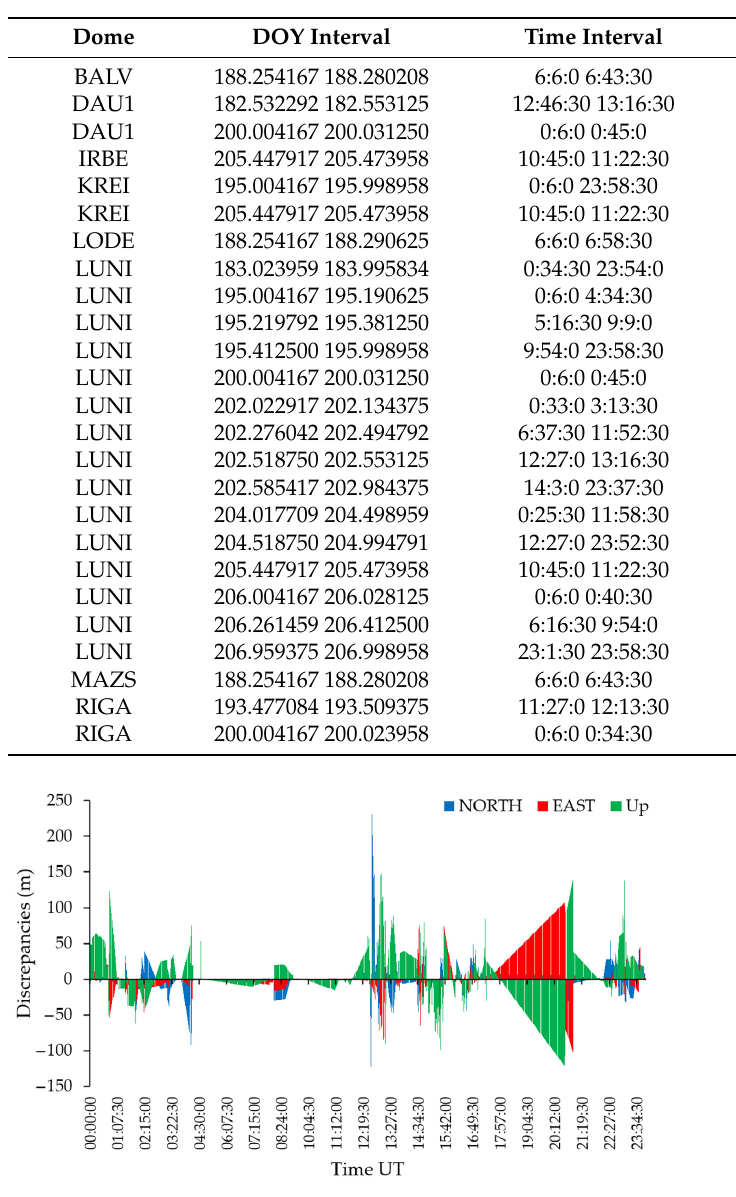
Figure 10. Plot of discrepancies of station LUNI on 14 July 2017.